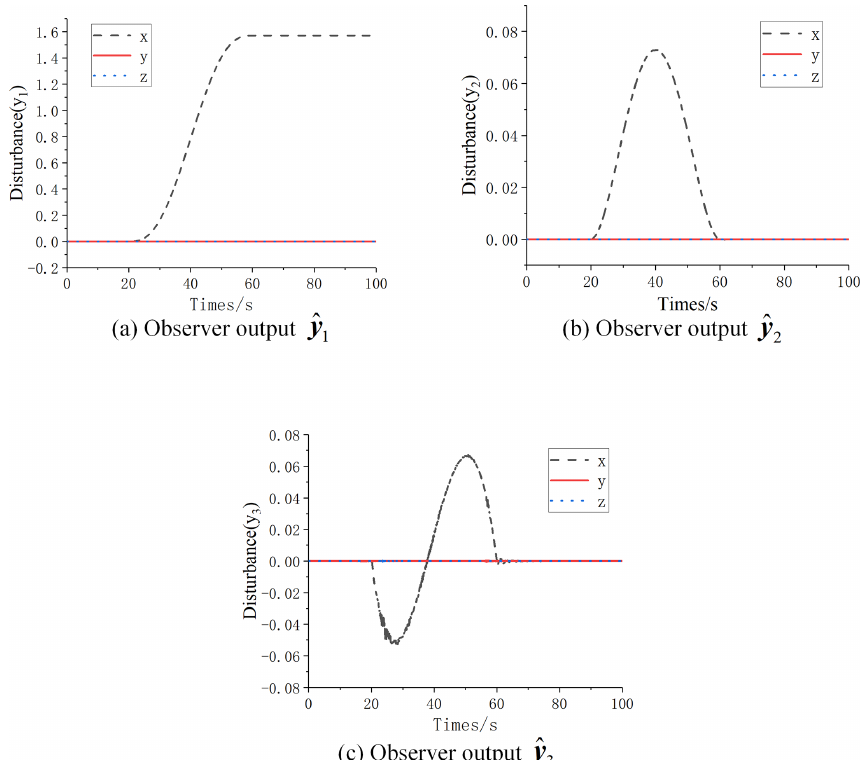
Figure 8. Attitude extended observer